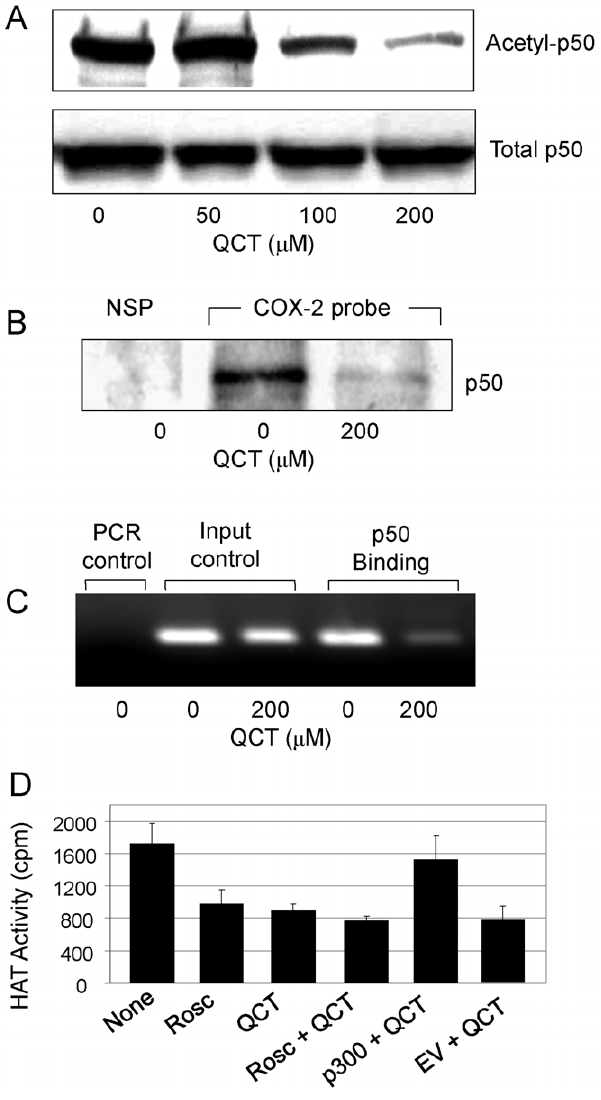
Figure 6. Quercetin inhibited NF- k B acetylation. ( A–C ), The MDA- MB-231 cells were transfected with FLAG-p300 for 24 h and then treated with quercetin for 24 h. Nuclear extracts were prepared and p50 was immunoprecipitated with a p50 antibody. Acetylated p50 (Actyl-p50) ( A ) was analyzed by Western blots using an acetyl-lysine antibody. The binding of p50 to a biotinylated COX-2 promoter probe ( B ) and chromatin structure ( C ) were detected by streptavidin-agarose pulldown and ChIP assay, respectively. ( D ), MDA-MB-231 cells were treated with roscovitine (20 m M) or quercetin (100 m M) for 24 h, then transfected with p300-expressing vector. After 24 h, the HAT activity was measured. The empty vector was used as a transfection control. The figures are representatives of three experiments. Each bar represents mean 6 SD of three experiments. *, P , 0.05, significant differences between treatment groups and control groups. NSP, non-specific probe; EV, empty vector.